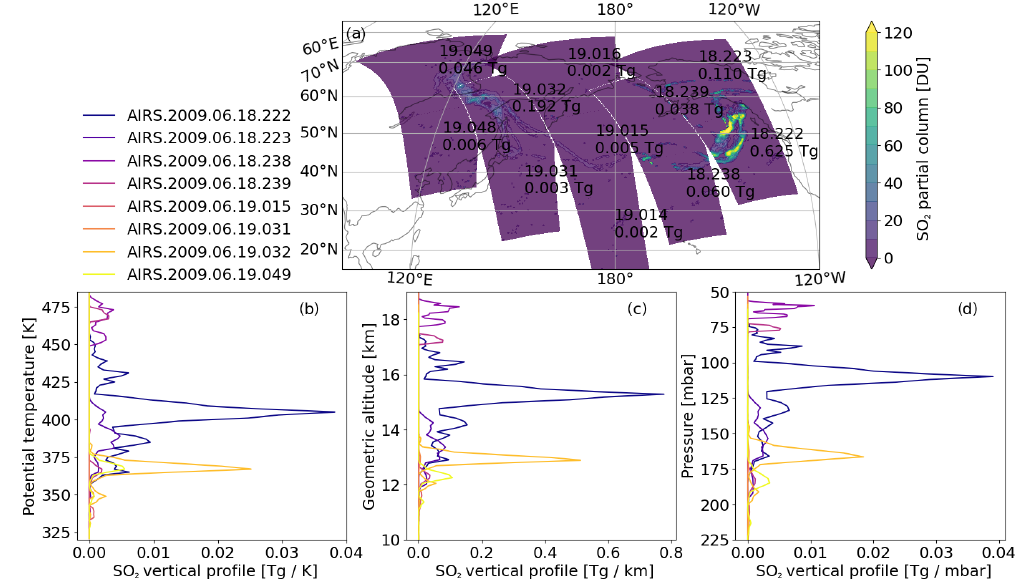
Figure 7. (a) A collection of AIRS SO 2 swaths spanning the entire volcanic cloud. The SO 2 mass in the wedge of missing coverage between swaths 18.222, 18.238, and 18.239 is estimated to be 0.036Tg (3% of the total mass). (b–d) Height profiles for the AIRS swaths in the collection shown in (a) and in potential temperature (b) , geometric altitude (c) , and pressure (d) . The number of CALIOP swaths that had air tracers transported into the SO 2 swaths were 18.222 (34 CALIOP swaths), 18.223 (34), 18.238 (17), 18.239 (25), 19.014 (1), 19.015 (5), 19.016 (6), 19.031 (5), 19.032 (20), 19.048 (8), and 19.049 (15). Vertical profiles were not compiled for three of the swaths in (a) , since the volcanic SO 2 concentration was very low, and no CALIOP data could be matched with these AIRS